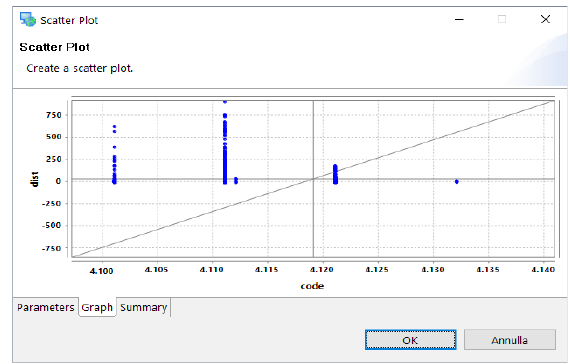
Figure 9. Create reports on vector data: scatter